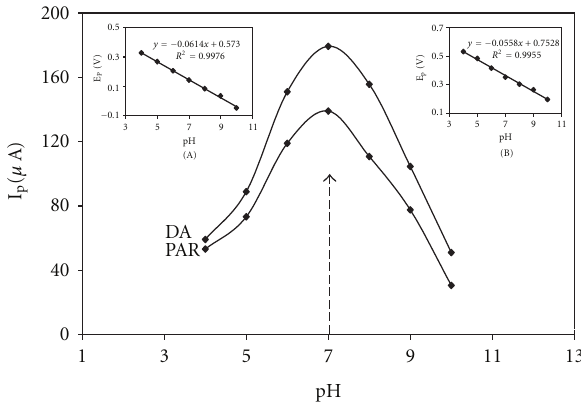
Figure 4: E ff ect of pH on the di ff erential pulse voltammogram peak currents of oxidations of DA and PAR compounds at MWCNTs/GCE in phosphate bu ff er solutions. Concentrations: DA: 200 μ M and PAR: 200 μ M. Insets: (A) plot of peak potential as a function of pH for DA. (B) Plot of peak potential as a function of pH for